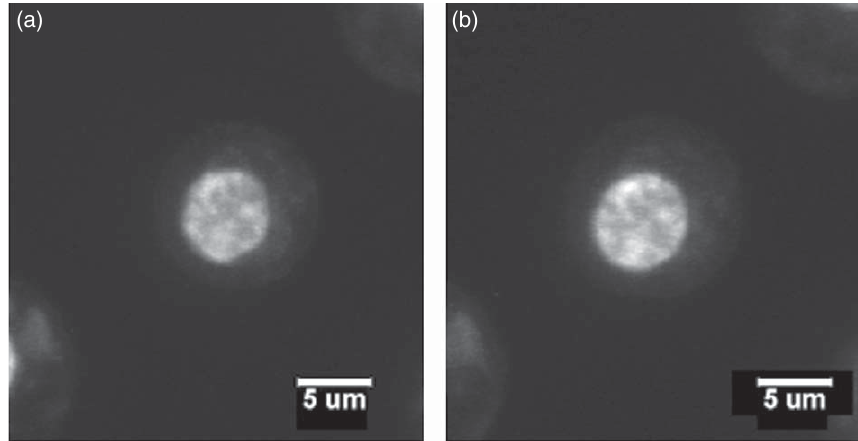
Fig. 9. Confocal images of stained chondrocyte cell nucleus equilibrated at (a) 500mOsm and (b) 330mOsm. At 500mOsm, the cell nucleus is smaller and less rounded than the cell nucleus equilibrated at 330mOsm, which is a typical observation in this experiment. Taken from